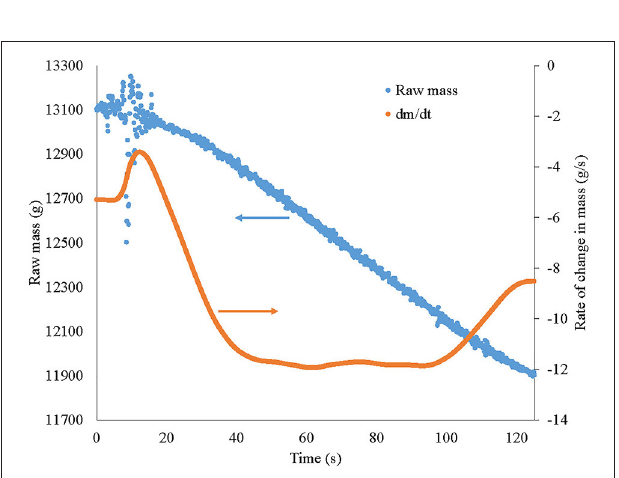
FIGURE 2 | Raw mass and rate of change data for crib design #4 in 0.24 m/s wind. Ignition occurs at about 10s, alcohol burnoff and stick ignition is complete by around 40s, and steady burning occurs between about 40 and